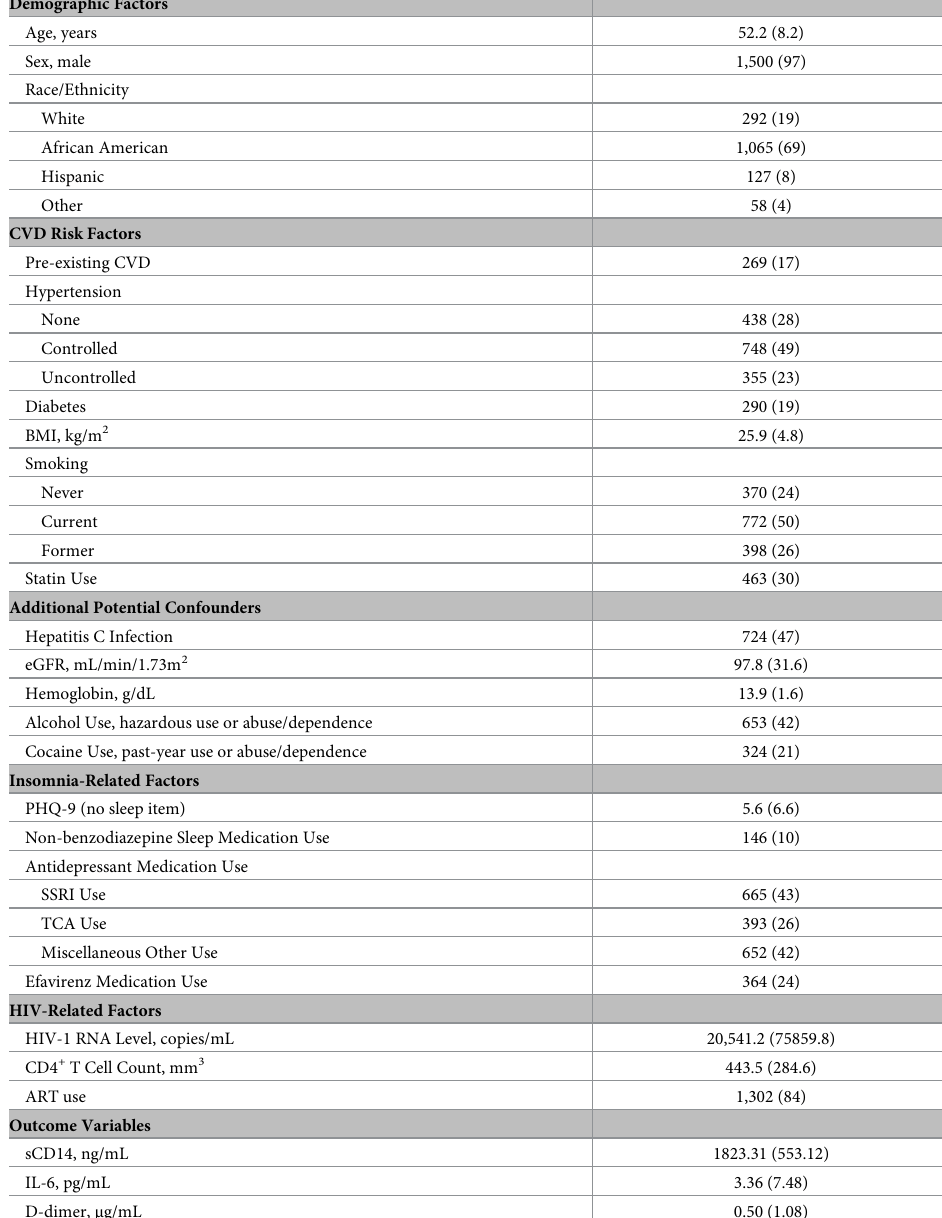
Table 1. Characteristics of veterans with HIV in the VACS biomarker cohort ( N =